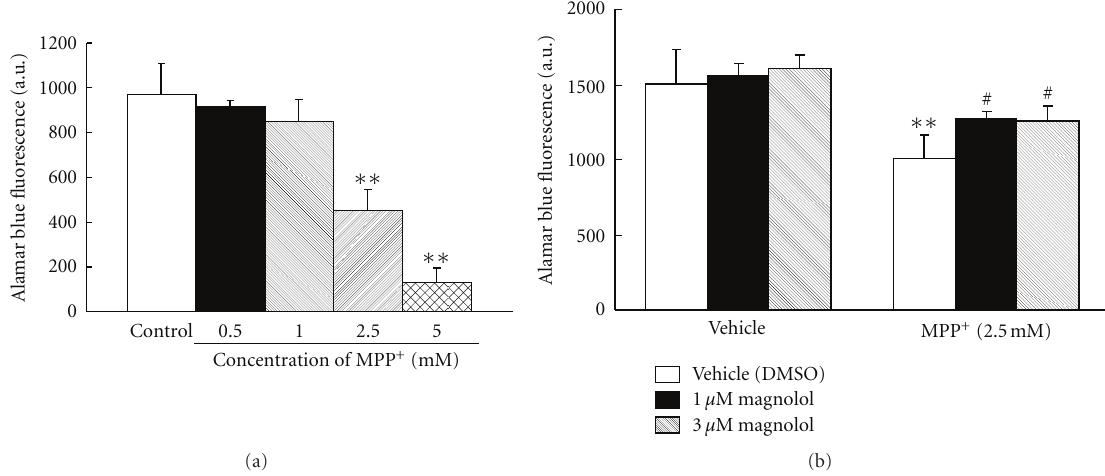
Figure 5: E ff ect of MPP + and/or magnolol on mitochondrial REDOX activity in human neuroblastoma SH-SY5Y cells. Cells were treated with 0.5–5.0 mM MPP + for 24 h (a). Cells were treated with 2.5mM MPP + in the presence or absence of magnolol (1 or 3 μ M) for 24 h (b). Mitochondrial REDOX activity was assessed by the Alamar blue assay. Alamar blue was added and cells were incubated for 120 min. These are representative results from at least three independent experiments. Results are means ± SD ( n = 4). Statistical comparisons were carried out by one-way ANOVA followed by Dunnett’s test. ∗∗ P < 0 . 01 versus control or vehicle (DMSO), # P < 0 . 05 versus MPP + + vehicle (DMSO).